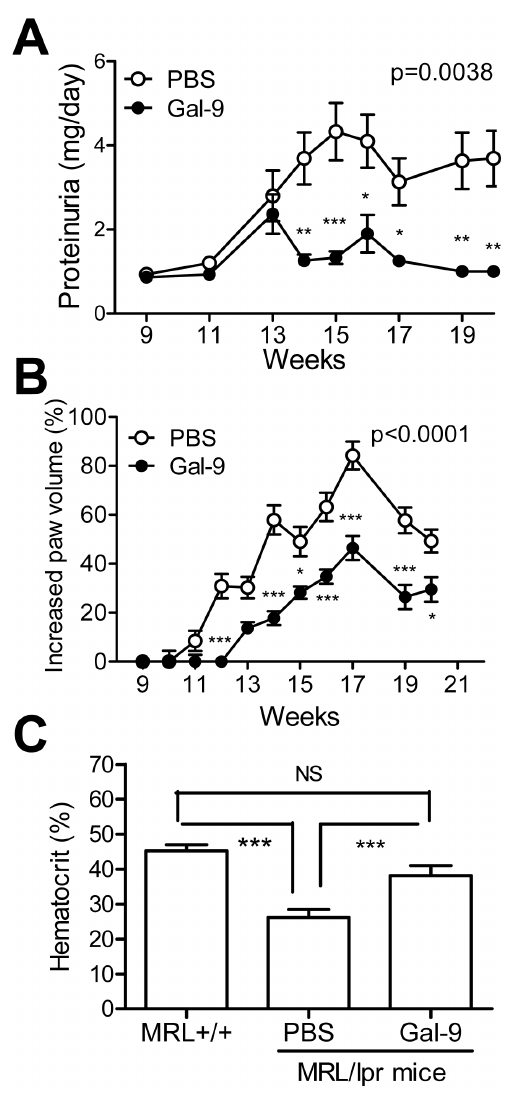
Figure 1. Effects of Gal-9 on lupus nephritis in MRL/lpr mice. ( A ) Comparison of proteinuria between PBS-treated (PBS) and Gal-9-treated (Gal-9) MRL/lpr lupus-prone mice. Gal-9 and PBS were injected intraperitoneally into 9-week-old MRL/lpr lupus-prone mice 3-times/ week until they were 20 weeks of age. Mean and SEM of PBS treated mice (n=10) and Gal-9 treated mice (n=8) are shown. (*, P , 0.05; **, P , 0.01, ***, P , 0.001). ( B ) Comparison of increase of paw volume between PBS and Gal-9-treated mice. Gal-9 or PBS was intraperitoneally injected to 9-week-old MRL/lpr lupus-prone mice 3-times/week until 20- weeks-old. Mean and SEM of PBS-treated (n=10) and Gal-9-treated mice (n=8) are shown. (*, P , 0.05, ***, P , 0.001). ( C ) Comparison of hematocrit between MRL + / + (MRL/lpr + / + ) mice and MRL/lpr (MRL/lpr 2 / 2 lupus-prone) mice in 20-week-old mice following treatment with PBS or human Gal-9. (***, P ,